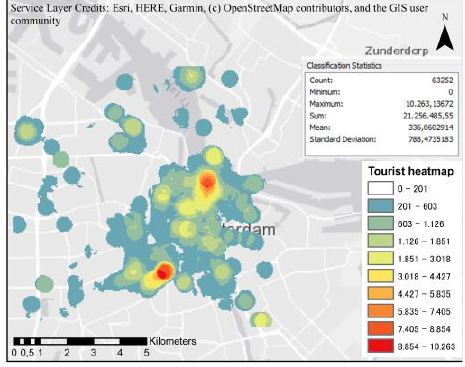
Figure 2. Heatmap of tourist’s photographs